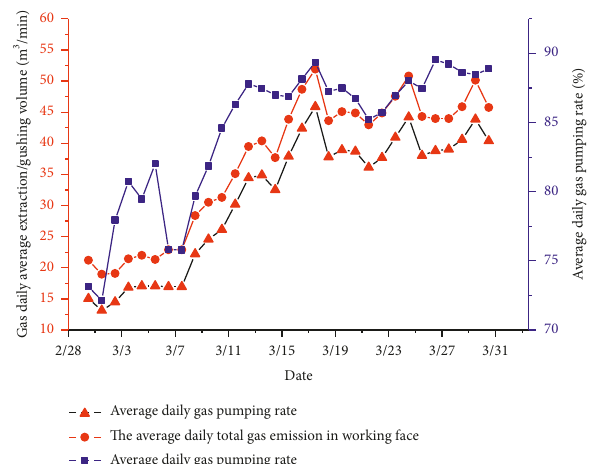
Figure 7: Curves of gas emission and extraction rate of the working